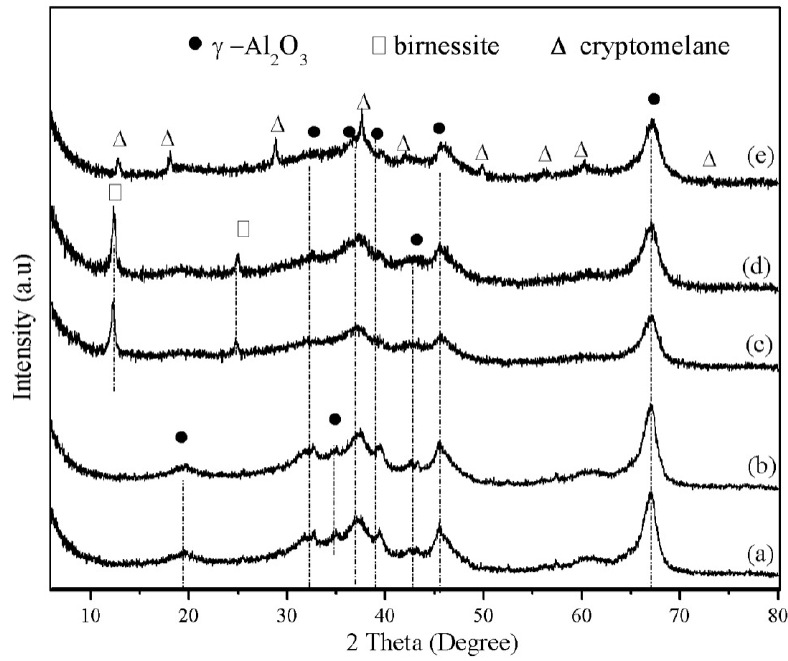
Figure 1. XRD patterns: (a) γ -Al ( c ) MnAlT400; ( d ) MnAlT400W and ( e )